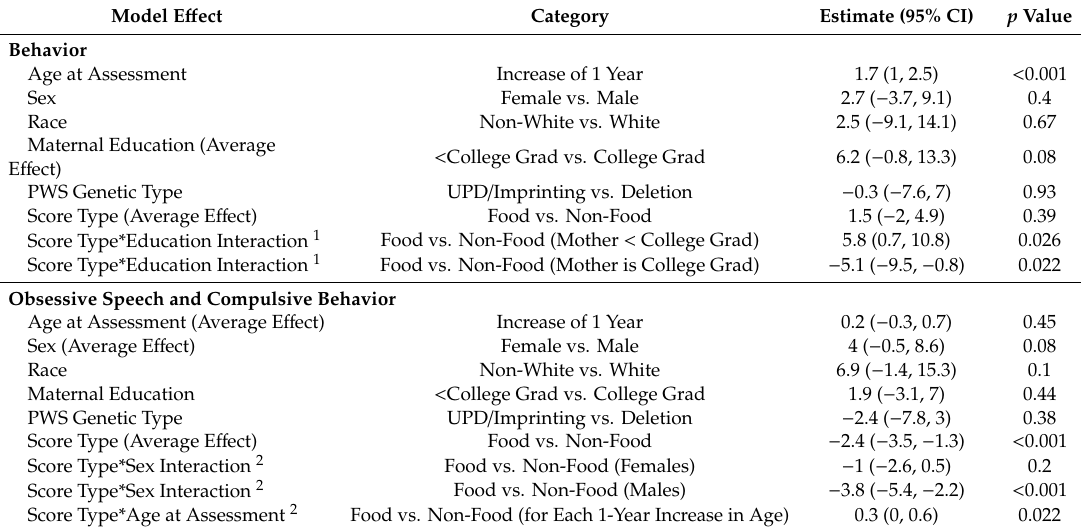
Table 4. Model Results Comparing Food- and Non-Food-Related Scores for Parent-Reported GAIB Subscales.